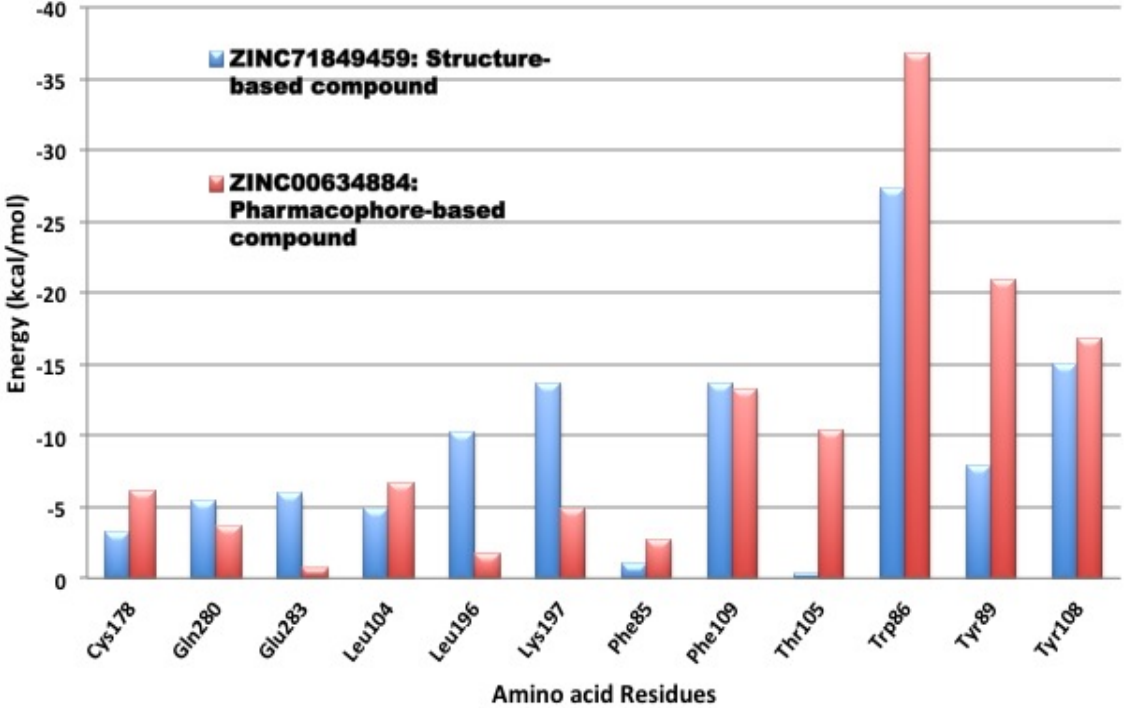
Figure 10. Per-residue interactions for the highest ranked compounds with the best binding energy from the structure-based and pharmacophore-based